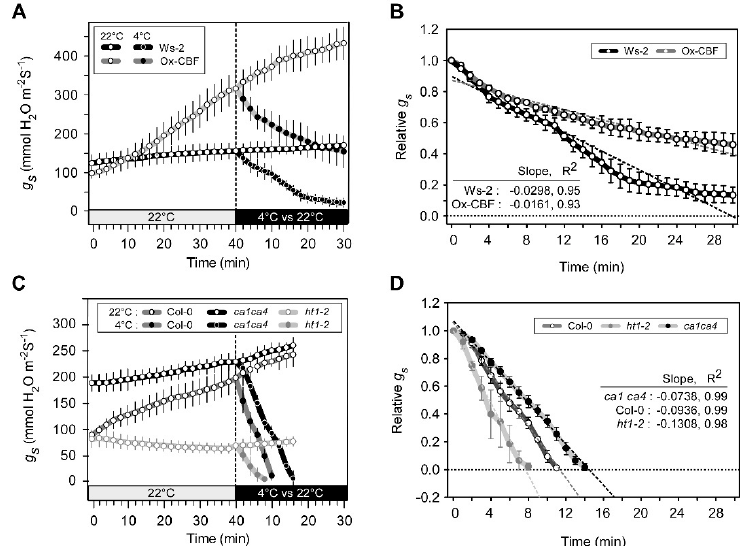
Figure 5. Relationship between CO 2 and cold signaling in stomatal movement.